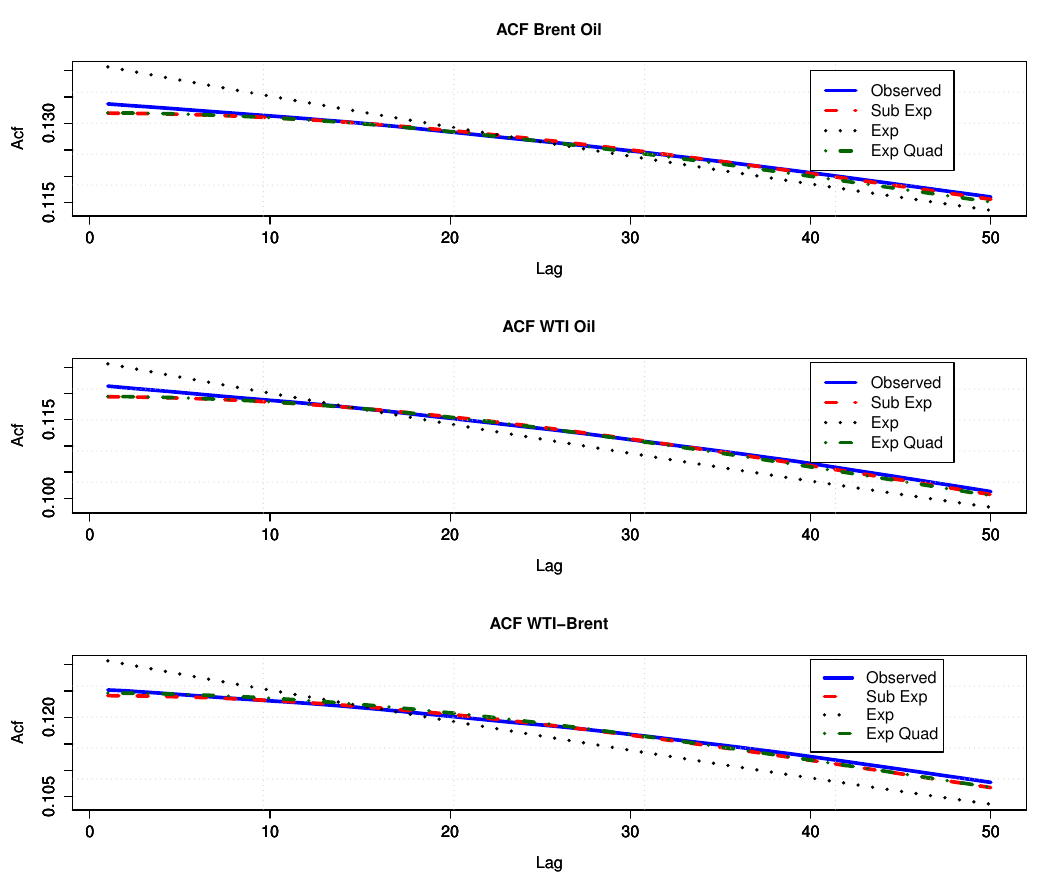
Figure 1. Plot of the autocovariance functions (ACF) of Brent and WTI oil log-returns. Time lags are expressed in days. “Observed”: empirical covariances. “Sub Exp”, “Exp” and “Exp quad”: sub exponental, exponential and quadratric exponential modeled